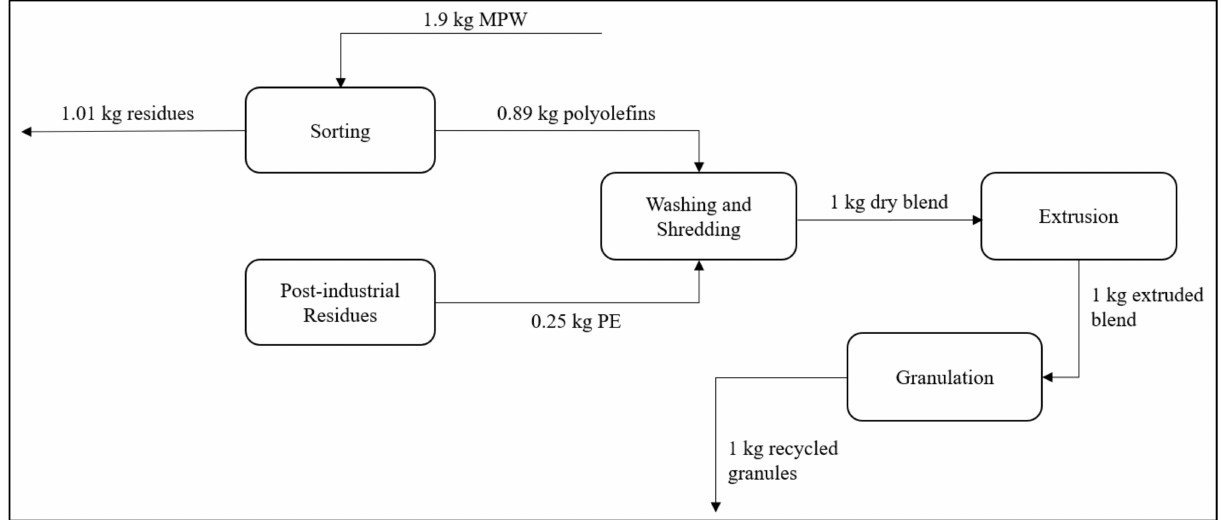
Figure 2. Graphical representation of the recycling process assessed via LCA. Mass flow for plastic materials is shown on arrows connecting each process. MPW: mixed plastic